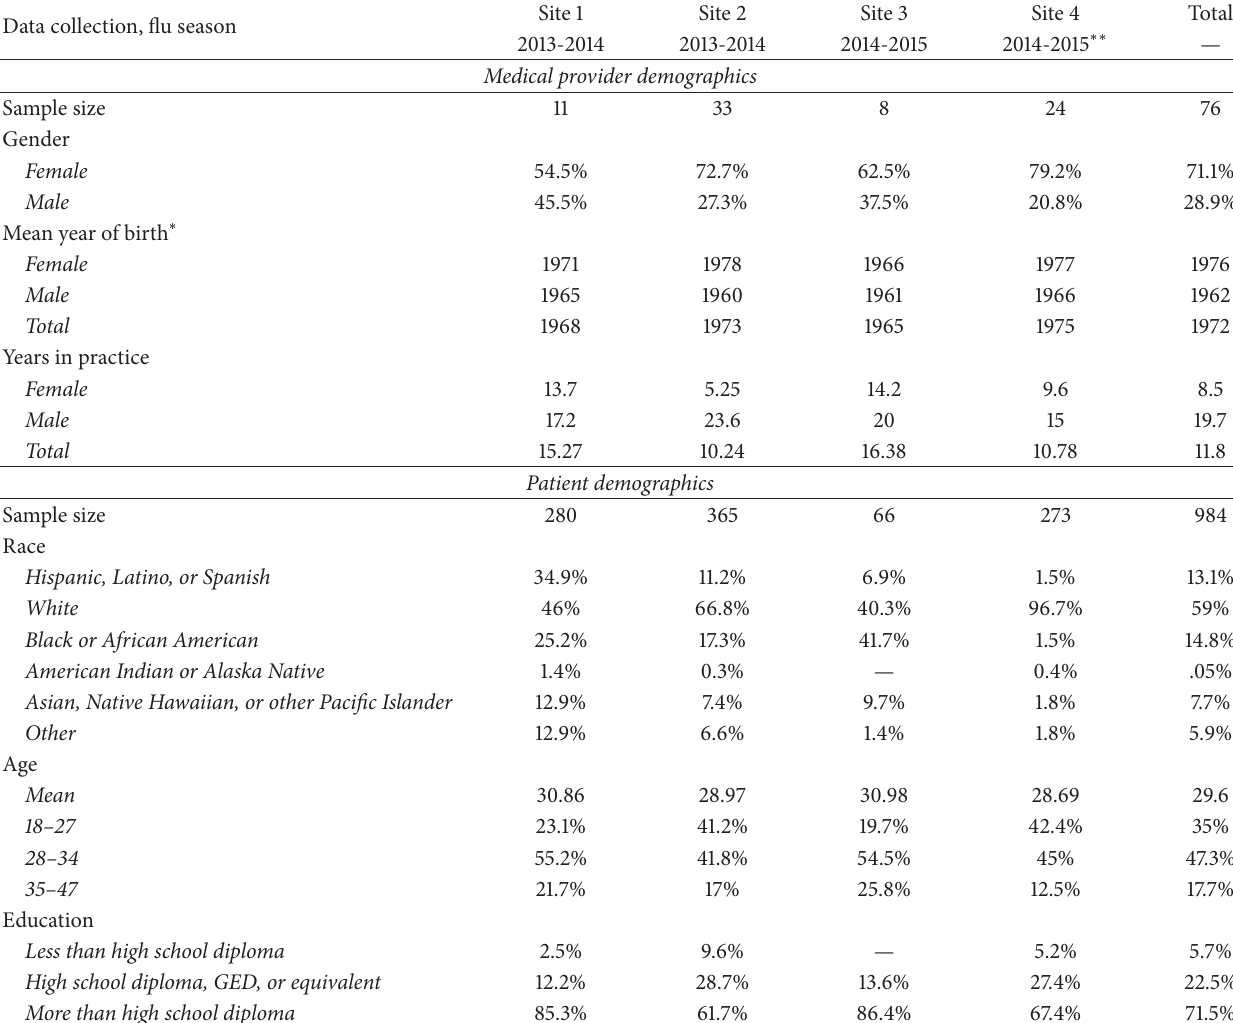
Table 1: Demographic